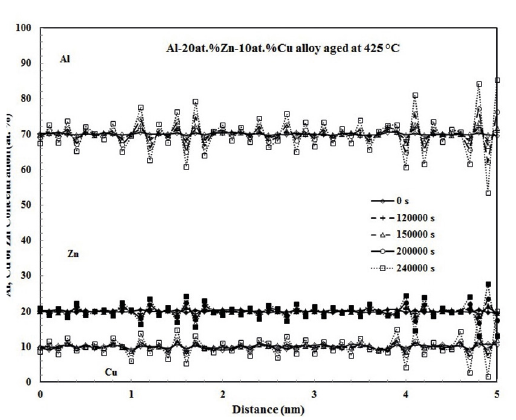
Figure 8. Al, Cu and Znn concentration profiles of the Al-20at.%Zn- 10at.%Cu aged at 425 °C for different times.